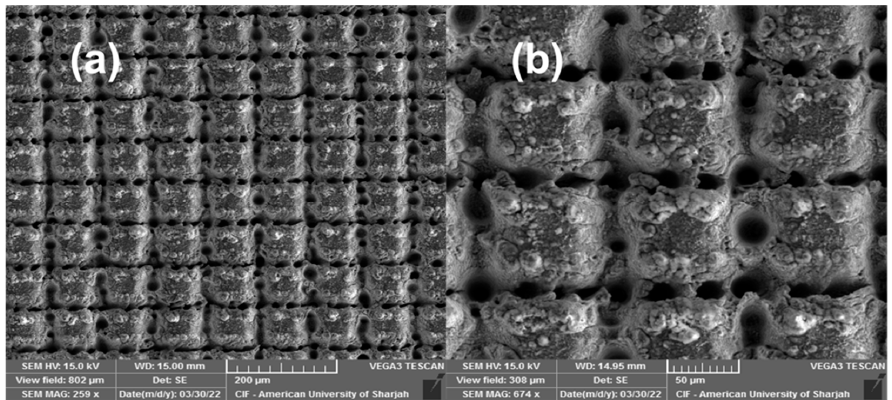
Figure 3. SEM images of laser-structured surfaces: ( a , b ) formation of microgroove structures on the Al 6061 surface as a result of femtosecond laser ablation.